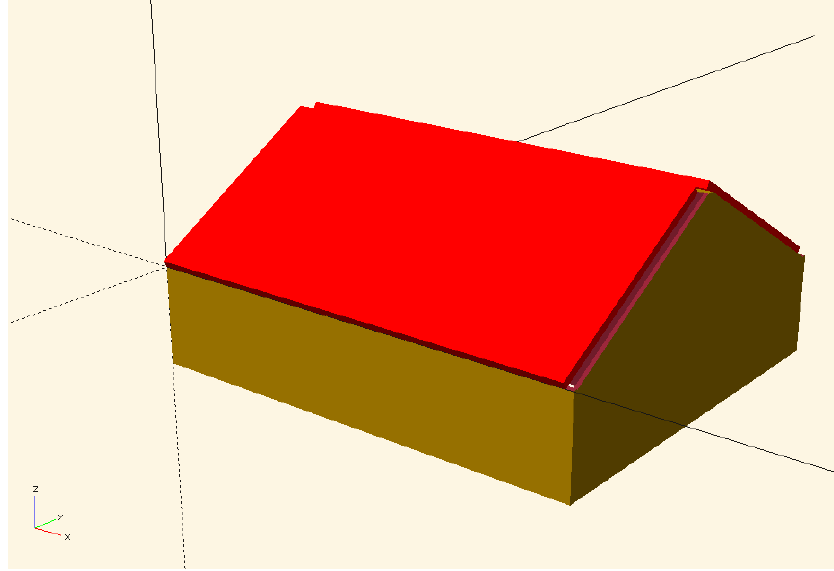
Figure 8 . A Double POSCAS design. Figure 8. A Double POSCAS